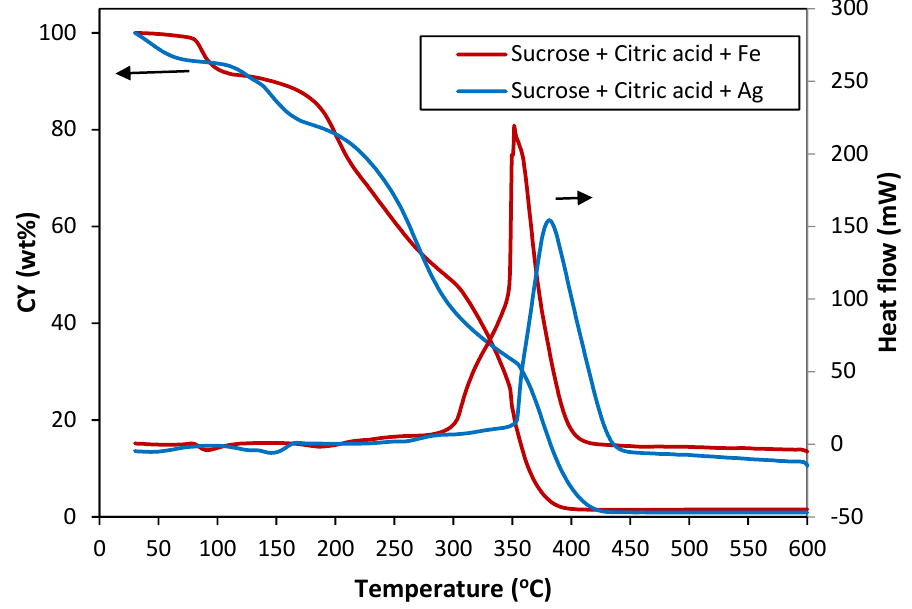
Figure 2. Weight loss (CY) and heat flow curves of sucrose with Fe(NO 3 ) 3 · 9 H 2 O (Fe)and AgNO 3 (Ag) in air atmosphere.